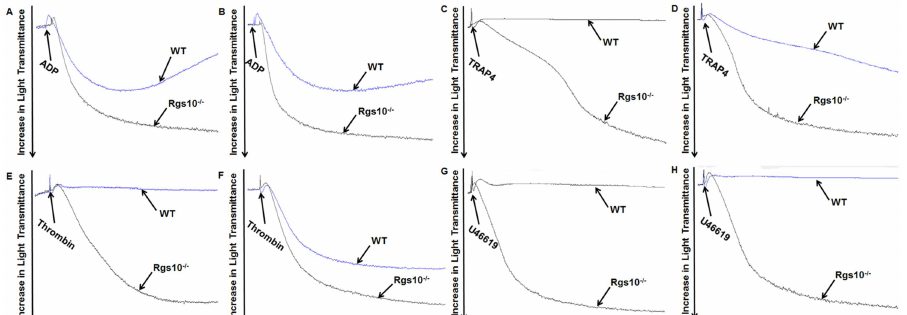
Fig 2. Deletion of RGS10 alters agonist-induced platelet activation. Platelets from Rgs10 -/- or WT mice (2 x 10 8 /ml) were exposed to (A) 1 μ M ADP, (B) 2.5 μ M ADP, (C) 40 μ M TRAP4, (D) 80 μ M TRAP4, (E) 0.1 U/ml thrombin, (F) 0.2 U/ml thrombin, (G) 0.25 μ M U46619, and (H) 0.5 μ M U46619. Platelet aggregation was measured using constant stirring. Each experiment was repeated at least 3 times, with blood pooled from a group of eight mice.